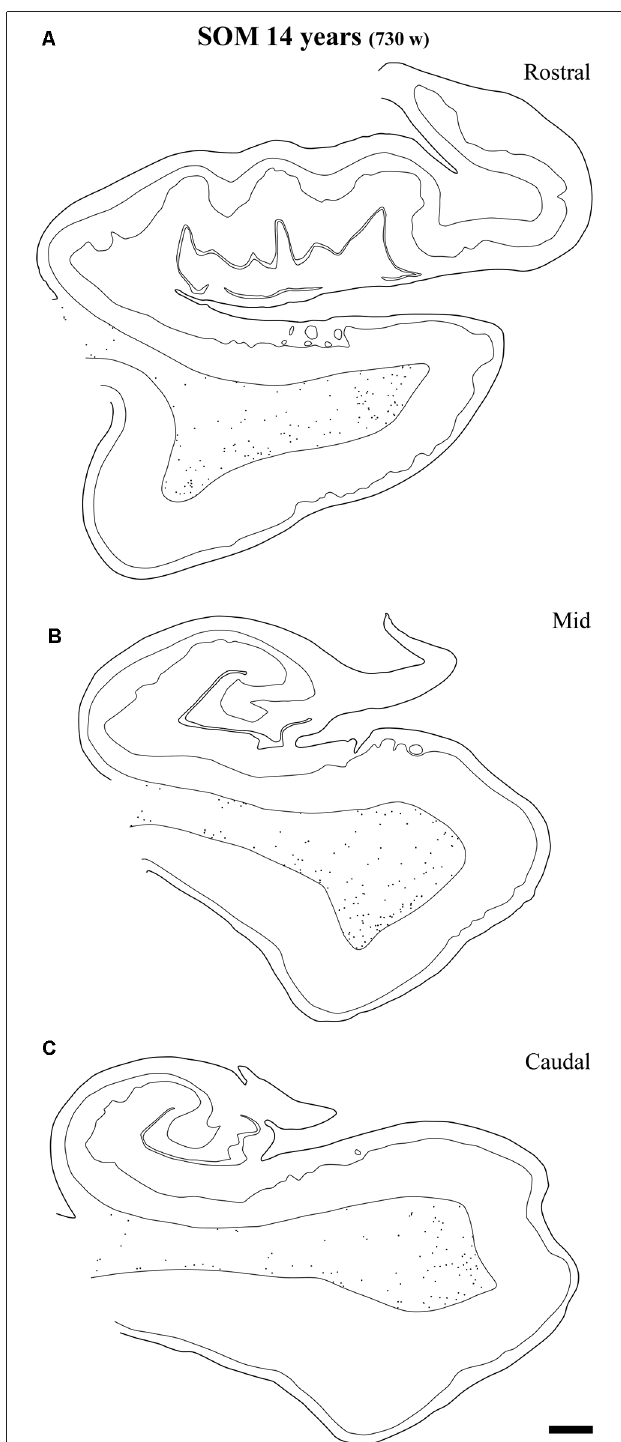
FIGURE 13 | Plots of SOM-28 positive neurons in the angular bundle at rostral (A) middle (B) and caudal (C) levels of the hippocampus at 14 years. Note the decrease in density at the three levels compared to younger ages, at the same time that the remaining neurons localize preferentially near the border of the gray matter with layer VI of the overlying cortex (entorhinal or parahippocampal cortices). Other conventions as in Figure 3 . Scale bar is 2